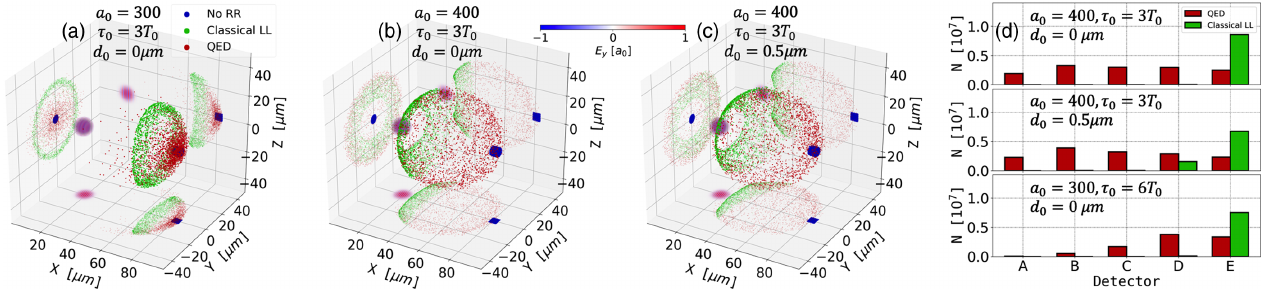
FIG. 4. (a) – (c) The electron three-dimensional distributions at 80 T 0 for different parameters (see Supplemental Material [78]). The blue, red, and green dots indicate the electron dynamics characterized by the Lorentz equation (without the RR), classical LL force, and QED discrete recoil, respectively. (d) presents the number of electrons measured by each